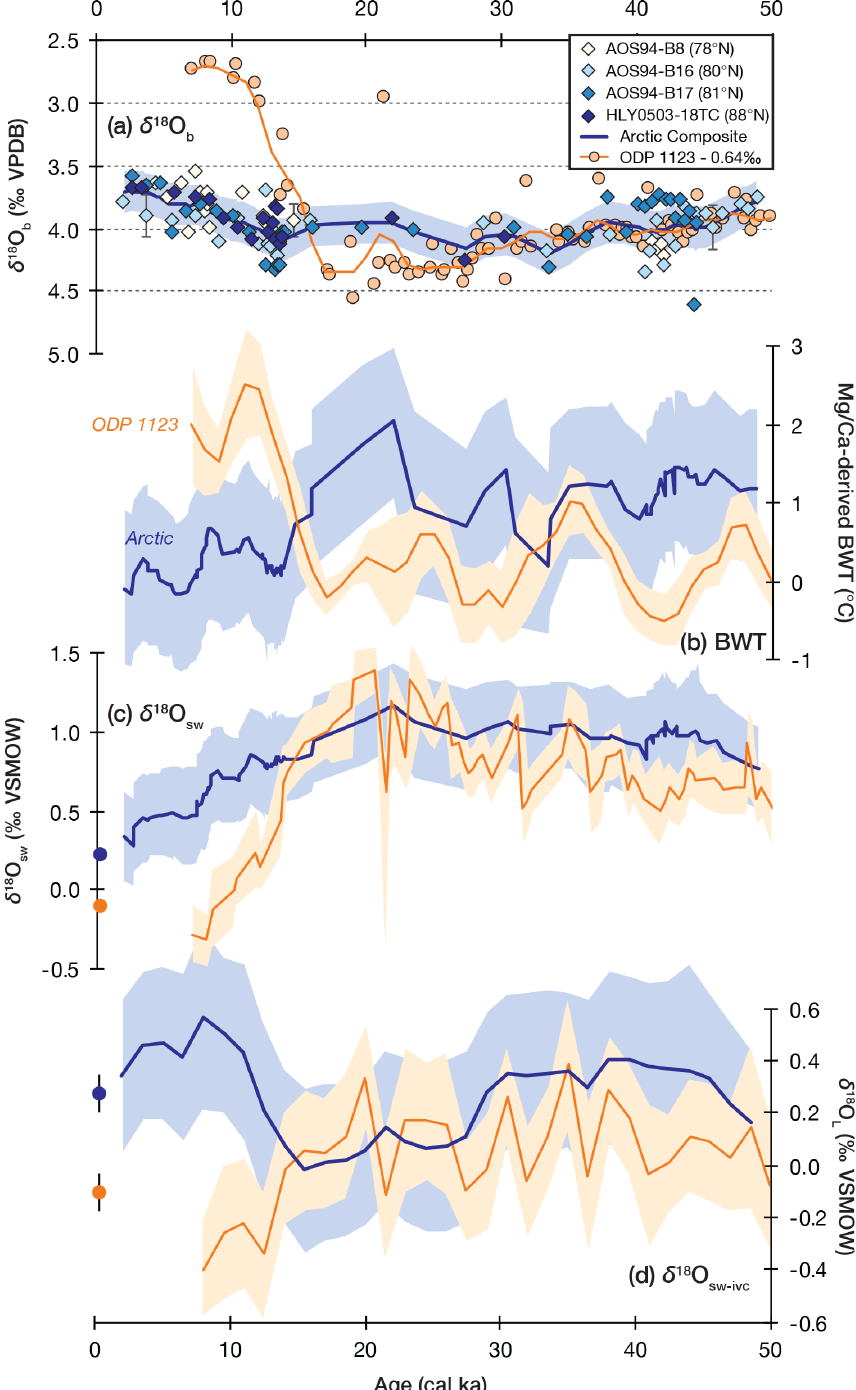
Figure 3. (a) δ 18 O b , (b) Mg / Ca-derived BWT, (c) δ 18 O sw , and (d) δ 18 O sw-ivc (ice volume corrected) over the last 50kyr from Arctic cores (diamonds are individual data points; blue lines are composited records) and ODP 1123 (orange circles are individual data points; orange lines are 1kyr interpolations; Elderfield et al., 2010). Shading denotes propagated 1SD equivalent errors (32% to 68% confidence intervals) calculated in PSU Solver (Thirumalai et al., 2016). Blue and orange circle in (c) and (d) denote the modern δ 18 O sw in Arctic Deep Water and at ODP Site 1123, respectively (Mackensen and Nam, 2014; Adkins et al., 2002).